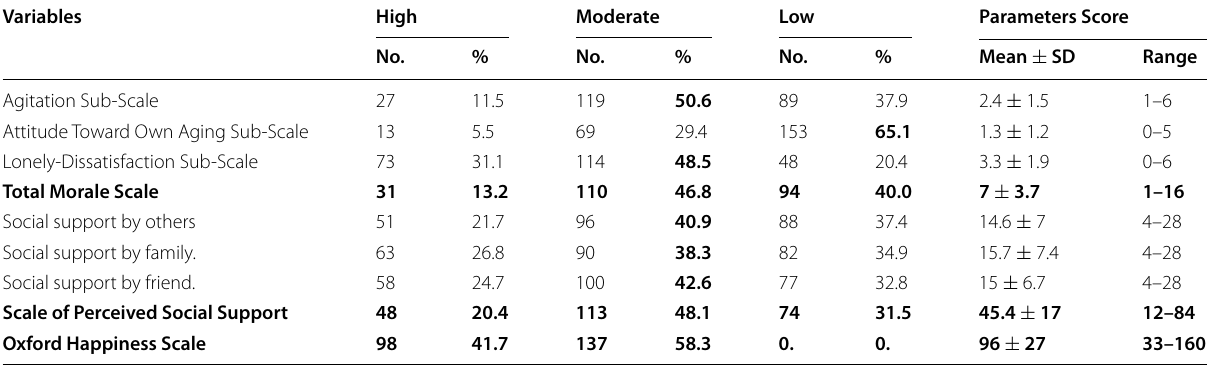
Table 3 Frequency distribution of morale level, perceived social support level and Oxford happiness level among studied elderly people ( n 235) =